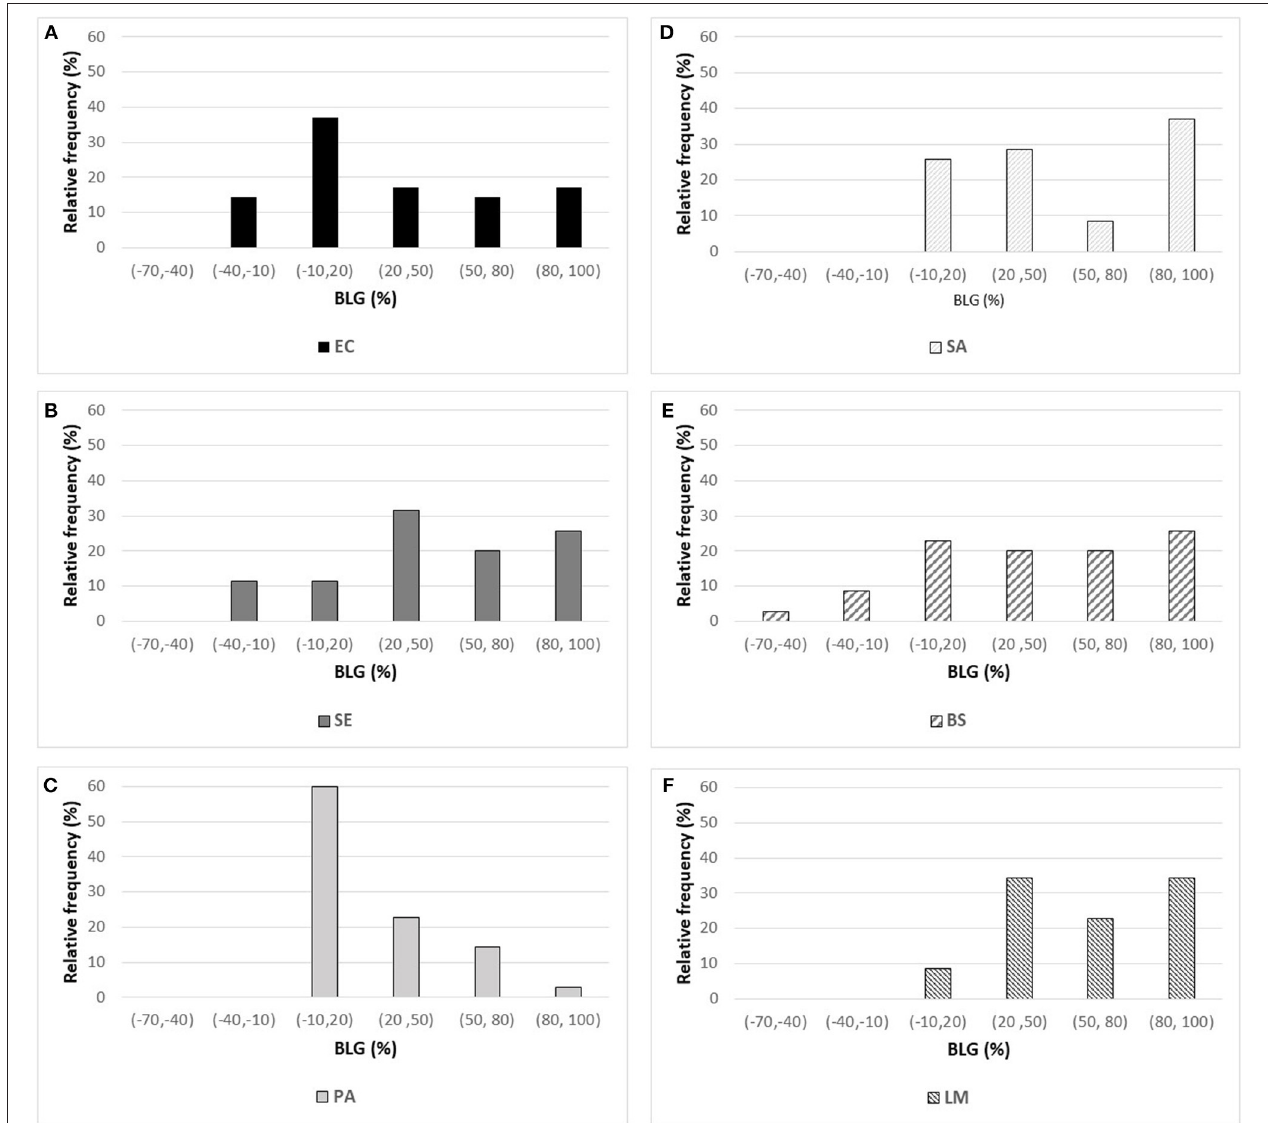
FIGURE 1 | Histogram of BLD experimental values measured for the 35 polyphenols against three Gram-negative bacteria [on the left: (A) E. coli ATCC25922 (EC), (B) S. Enteritidis E0220 (SE), and (C) P. aeruginosa ATCC27853 (PA)] and three Gram-positive bacteria [on the right: (D) S. aureus CNRZ3 (SA), (E) B. subtilis ATCC6633 (BS), and (F) L. monocytogenes ATCC19115